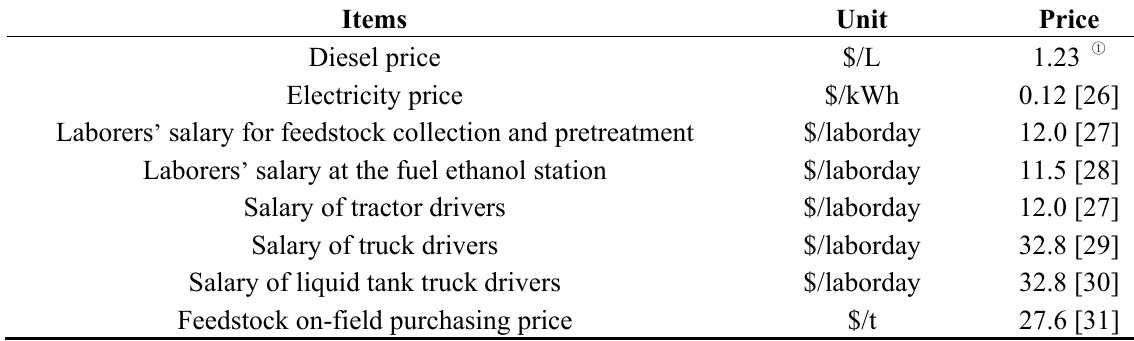
Table 6. Prices used in feedstock cost estimation.